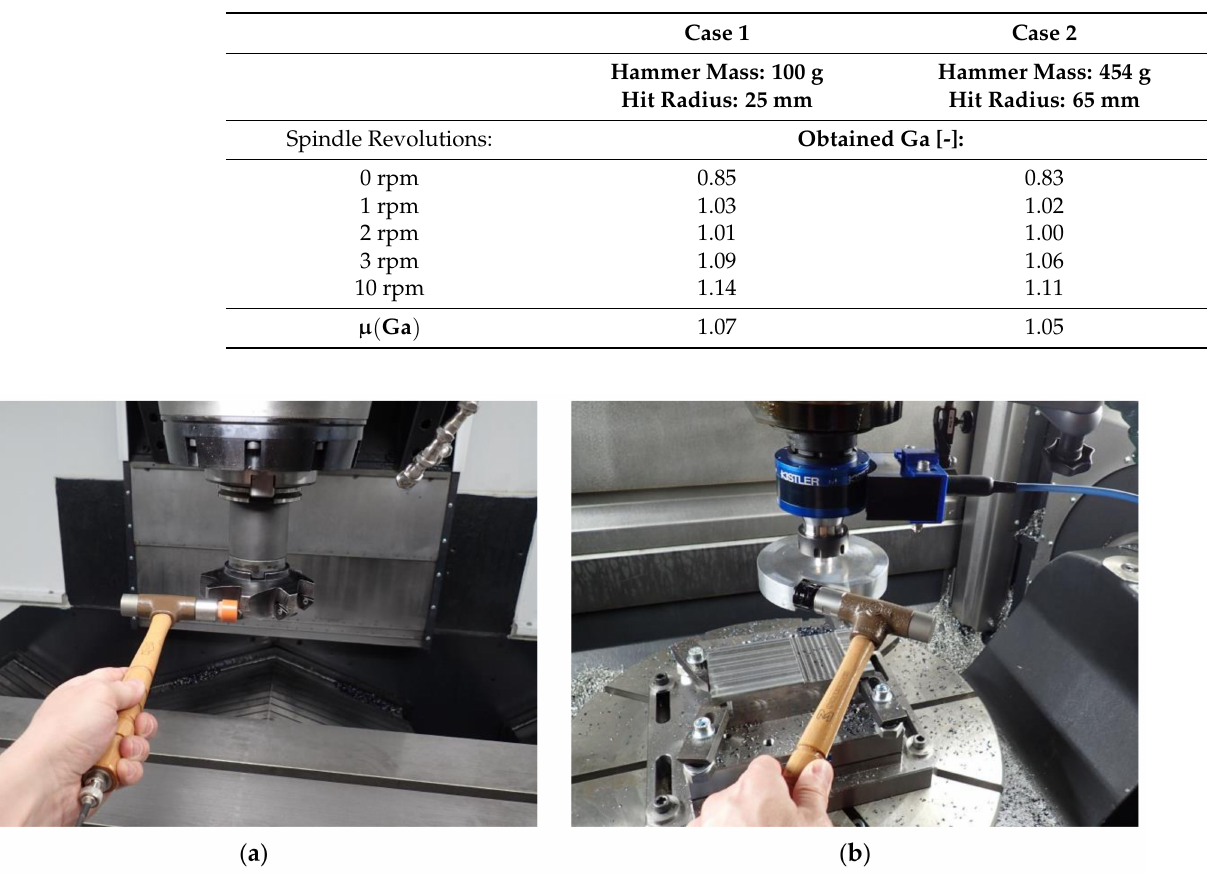
Table 1. Calibration result for different hammers acting on different radii.